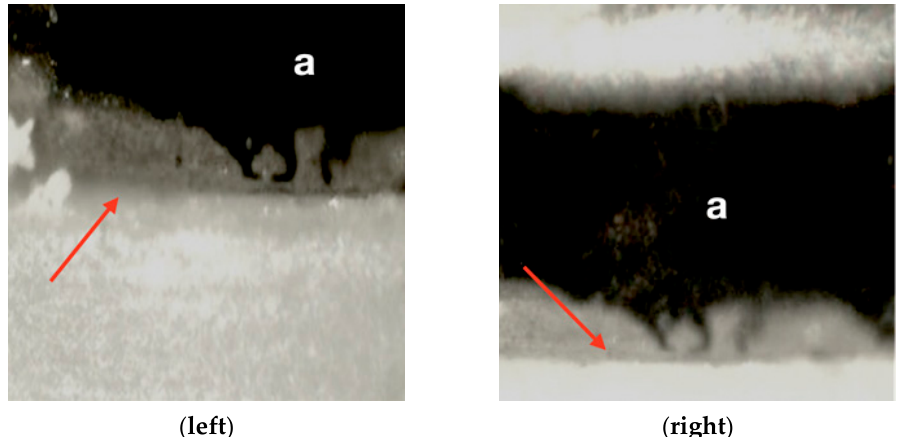
Figure 6. Detail of the microscopic analysis of the micromovement test ( left ) moment prior to loading (F = 01), ( right ) moment during the application of the 50 N load (F = 1). In both images, the “a” indicates the reference mark added to the abutment and the red arrows indicate the transition area between the prosthetic abutment and the smooth collar of the implant.